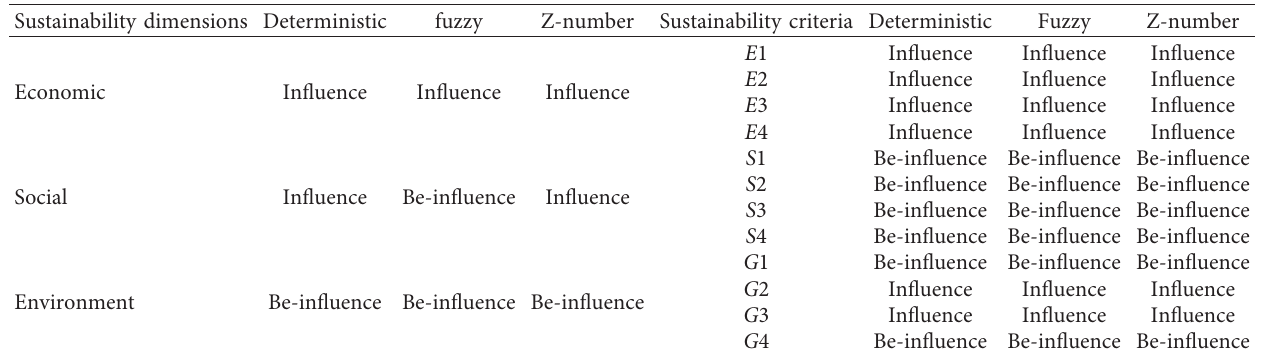
Table 51: The results of the effectiveness and influence of the dimensions and criteria of sustainability in different scenarios.